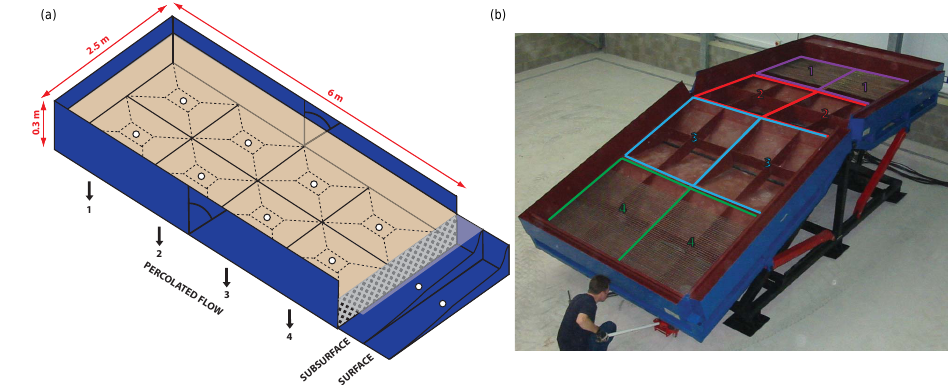
Figure 1. (a) Schematic showing sampling outlets on the TRACE slope and (b) photo showing the empty slope.